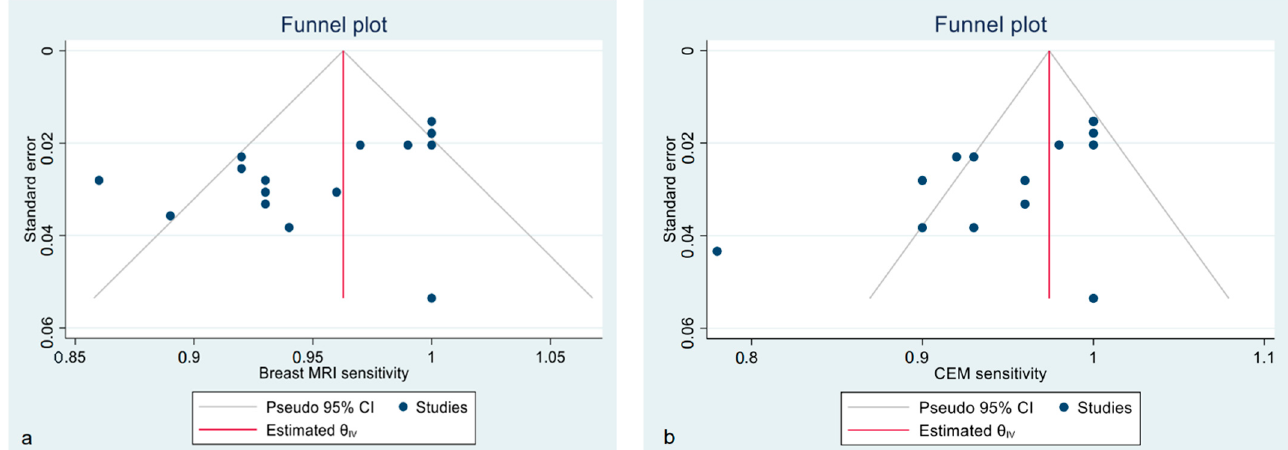
Figure 3. Funnel plot with 95% CIs for publication bias assessment of pooled sensitivity of CE-MRI ( a ) and CEM ( b ) in the detection of pathological breast lesions (considering both index and secondary lesions).